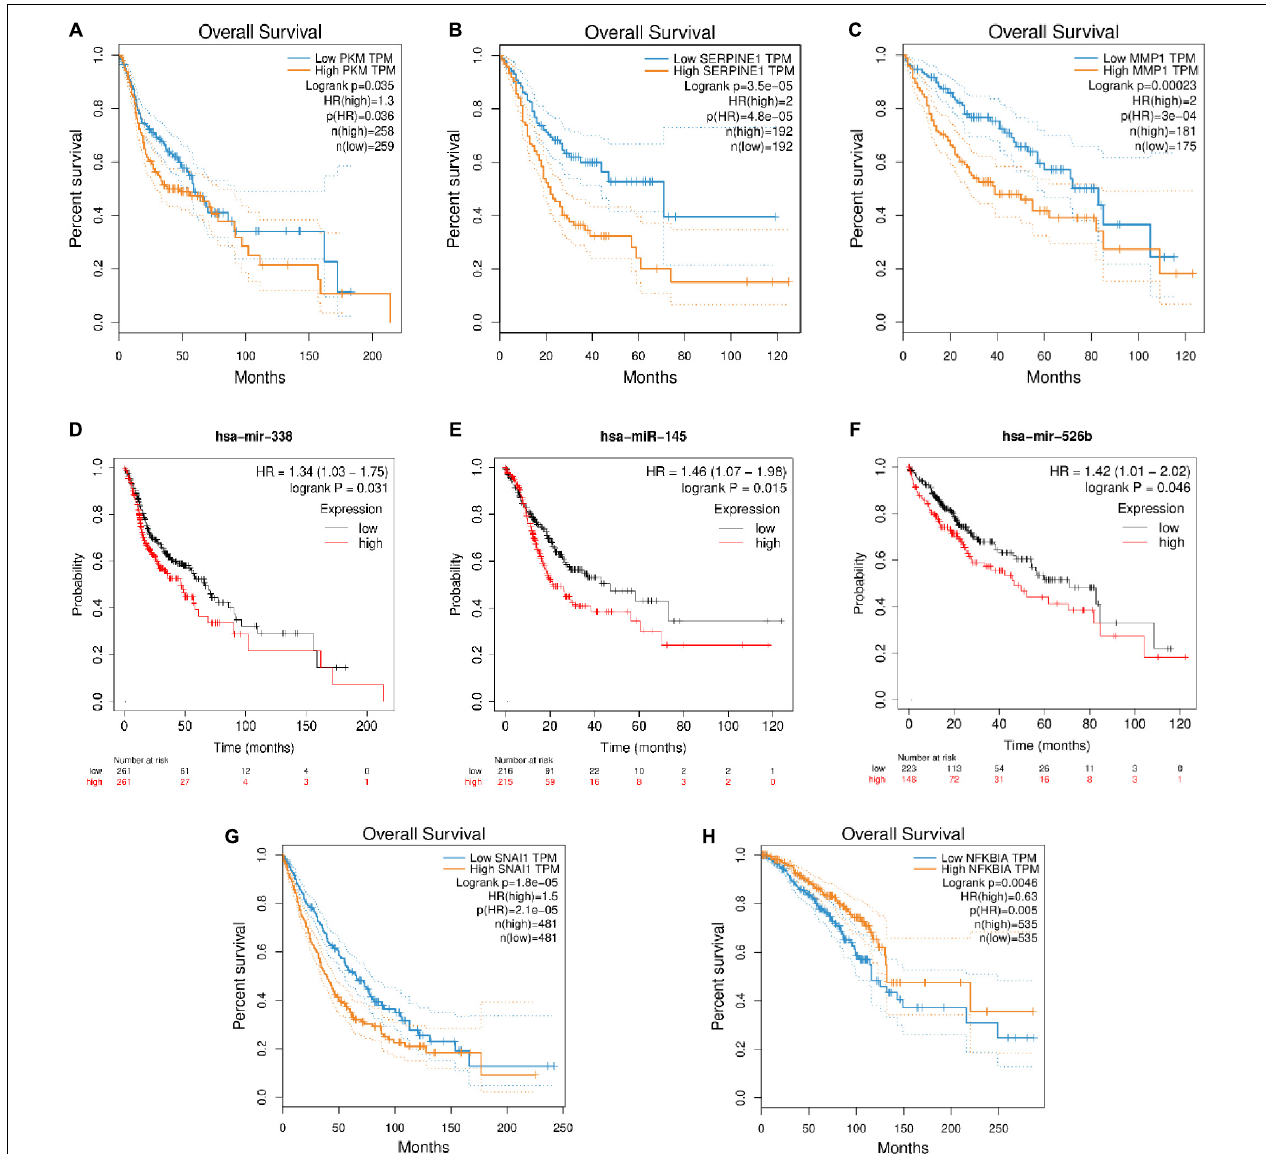
FIGURE 6 | The survival plots for (A) PKM and its corresponding miRNA, (D) has-miR-338-5p in HNSCC, (B) SERPINE1 and its corresponding miRNA, (E) hsa-miR-145 in gastric cancer, (C) MMP1 and its corresponding miRNA, (F) hsa-miR-526b in liver cancer, (G) SNAI1 in lung cancer and (H) NFKBIA in breast